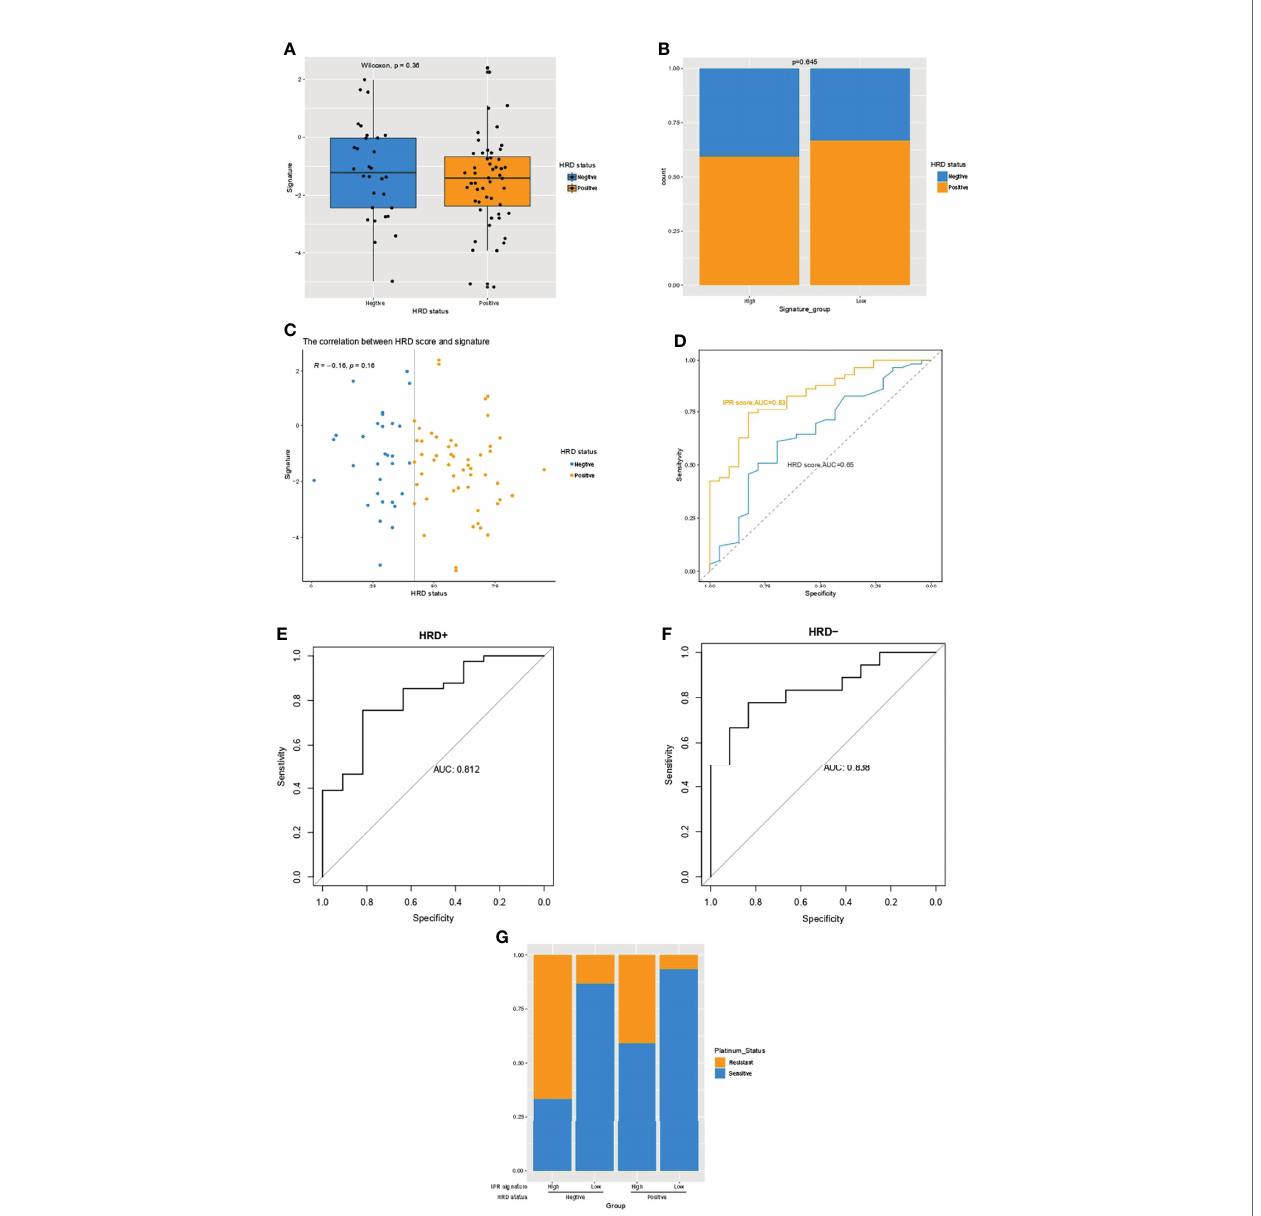
FIGURE 3 | The relationship between HRD and the IPR signature in the training cohort. (A) The difference in the IPR signature score between OC samples with HRD and HRP. (B) There was no signi fi cance in the prevalence of HRD between samples with high- or low-IPR signature. (C) Correlation between IPR signature score and HRD score. (D) Comparison of the IPR prediction capacity between IPR signature and HRD score. The prediction ef fi cacy was stable in both the HRD (E) and HRP (F) samples. (G) The prevalence of platinum resistance in samples with different HRD and IPR signature. HRD, homologous recombination de fi ciency; HRP, homologous recombination pro fi ciency; IPR, initial platinum